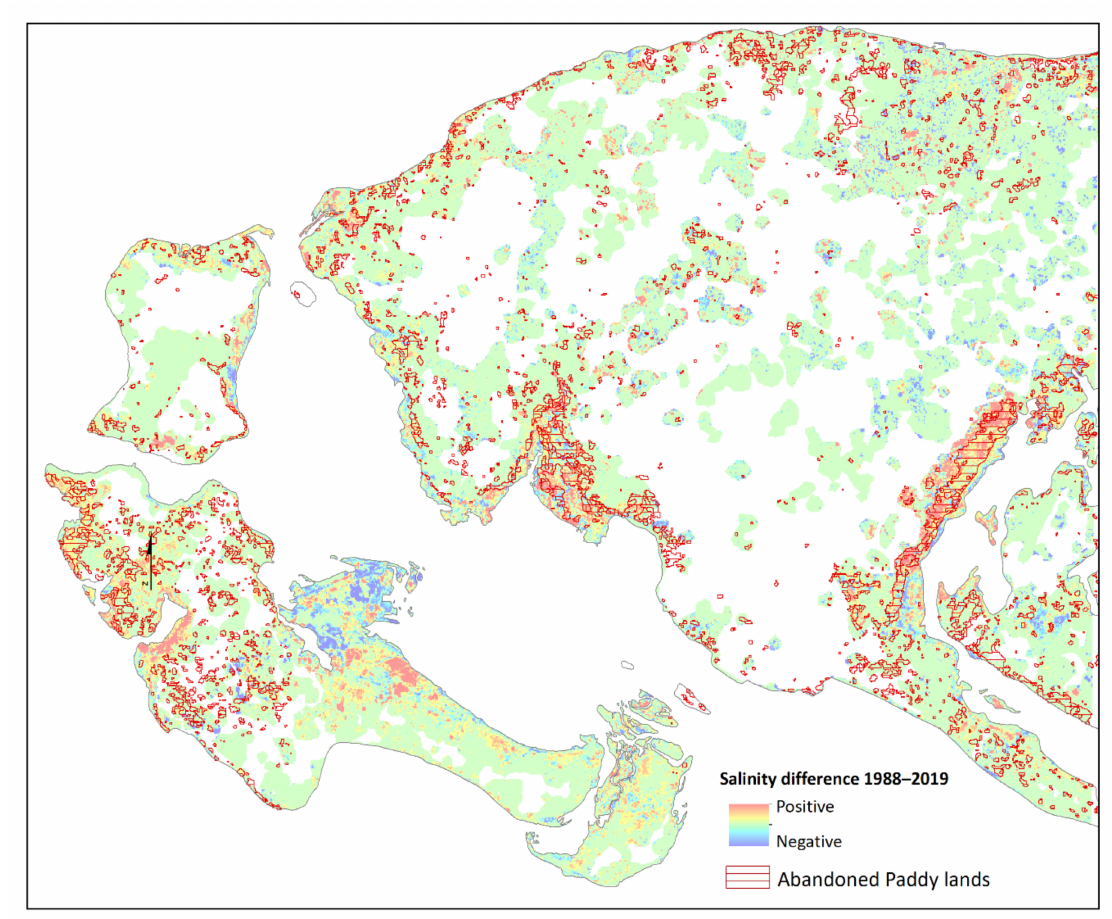
Figure 7. Permanently abandoned paddy lands overlaid on salinity difference